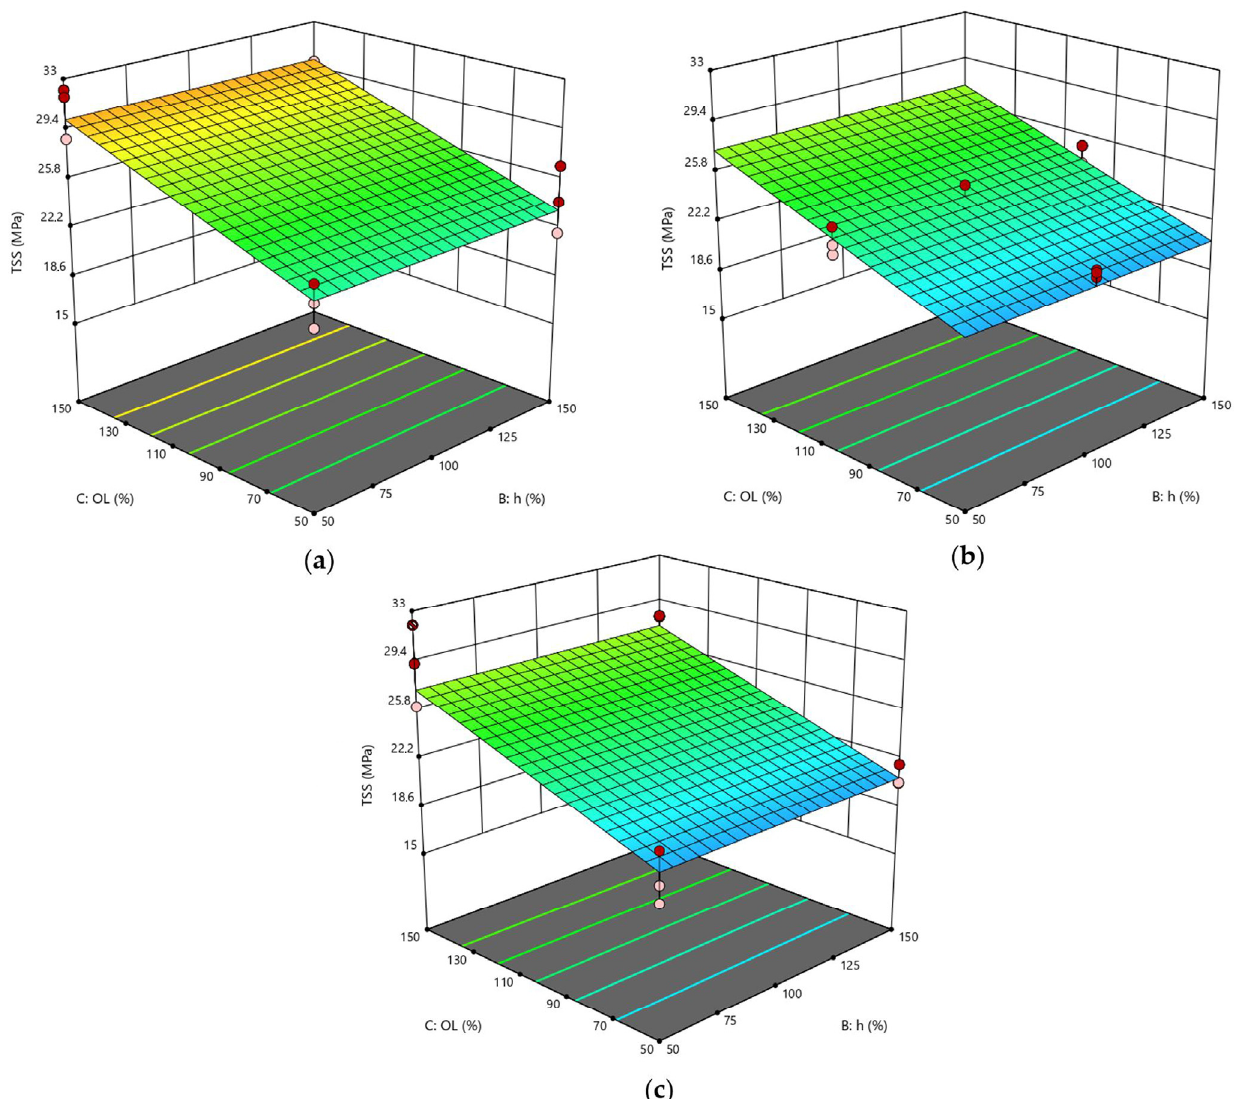
Figure 7. RSD 1: ( a ) P = 20 W; ( b ) P = 35 W; ( c ) P = 50 W.